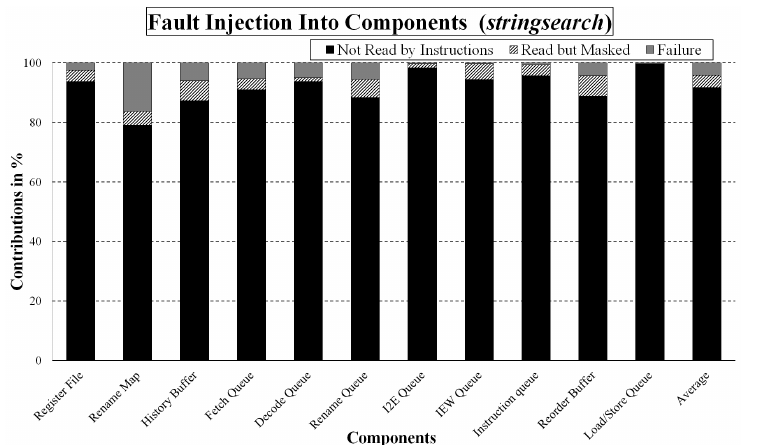
Figure 10. Faultinjection campaignsinto allthe microarchitecturalcomponents (Benchmark: